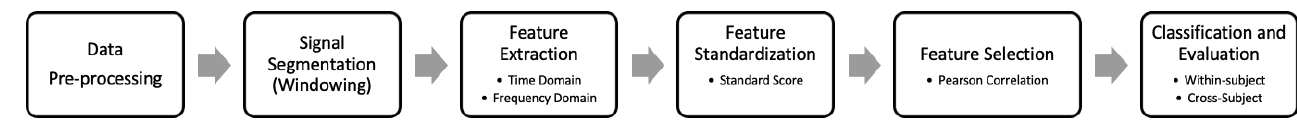
Figure 2. Human activity recognition